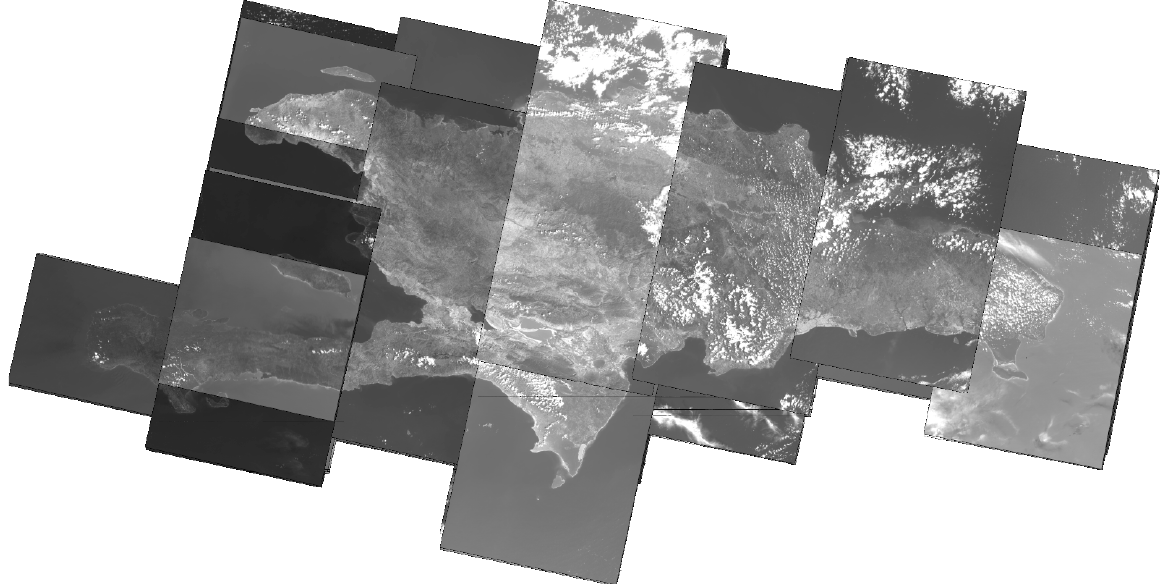
Figure 2. Spot5-HRS times series. Illustration for the Hispaniola test area ©